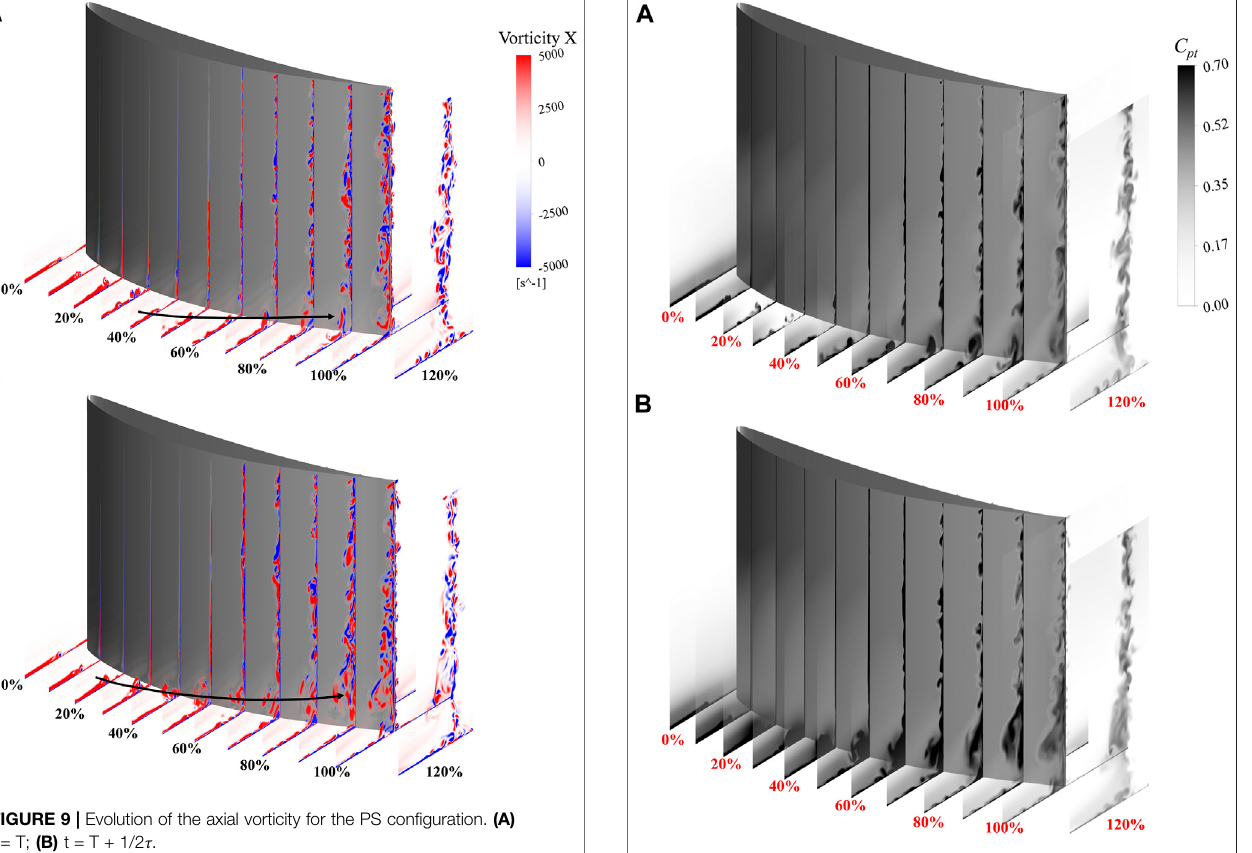
FIGURE 10 | Evolution of the C pt for the PS con fi guration. (A) t = T; (B) t = T + 1/2 τ